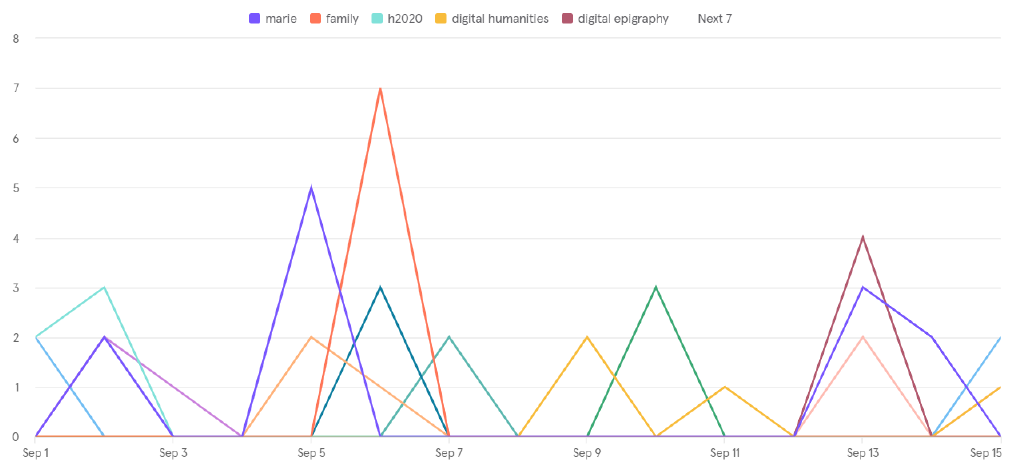
Figure 5. Example of an initial dashboard concept based on existing data retrieved from the GoTriple platform, displaying the key search terms for the period 1–15 September 2022